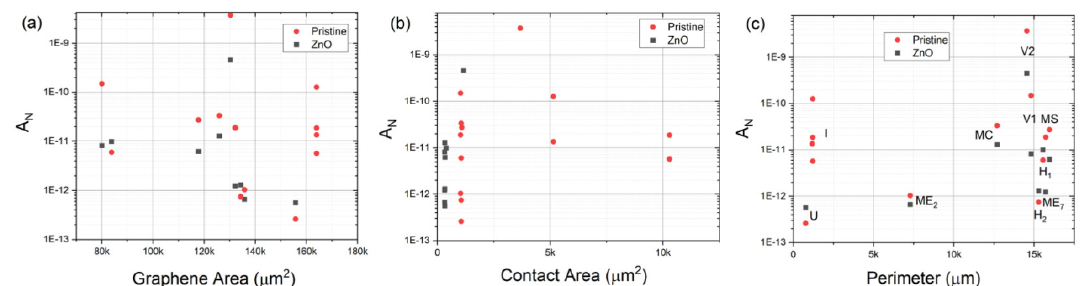
Figure 6. Noise scalar A N plotted against ( a ) graphene area, ( b ) contact area, and ( c ) total perimeter for both pristine and ZnO functionalized graphene